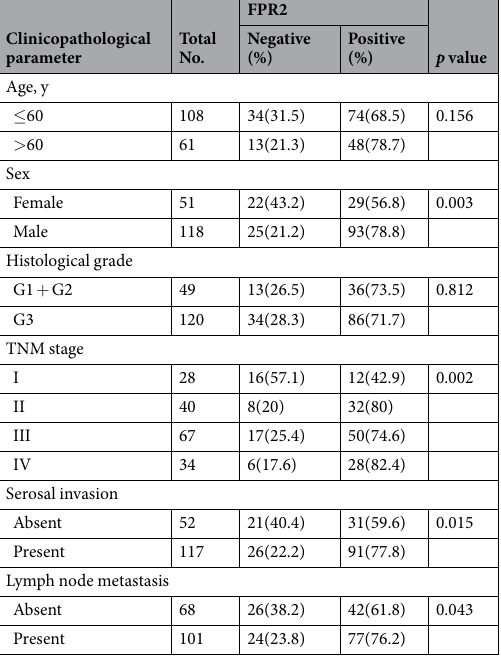
Table 1. The correlation between FPR2 expression and clinical pathologic parameters in GC.